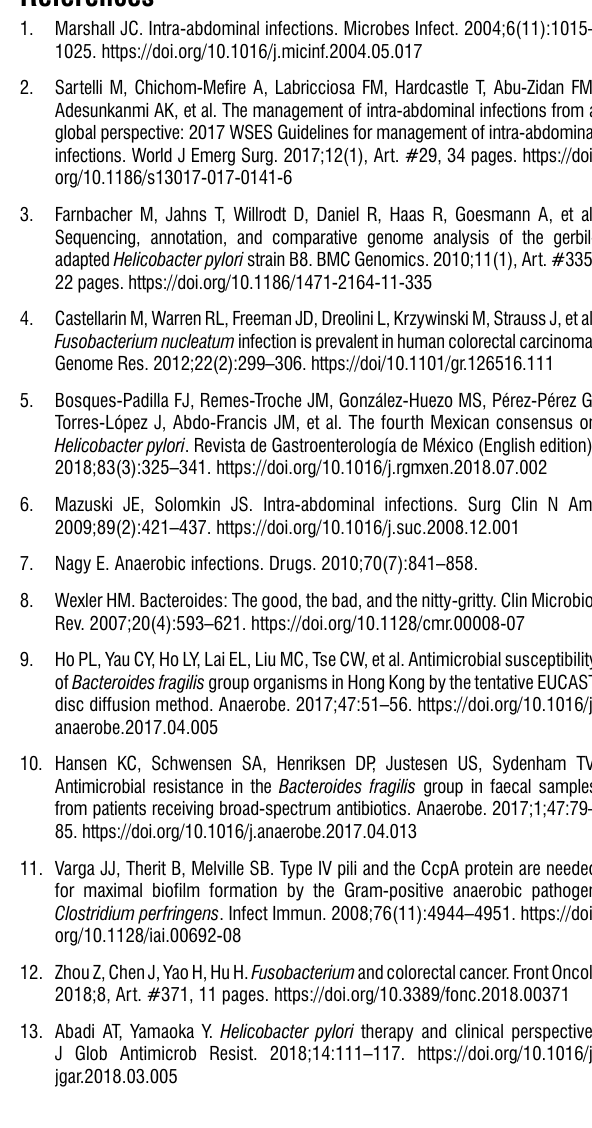
LC ( μg/mL) values of plant samples that displayed 50 cytotoxic effects LC (µg/mL) Plant part 50 Plant extract used 24 h 48 h Acokanthera oppositifolia 984 Antidesma venosum Lippia javanica Tetradenia riparia